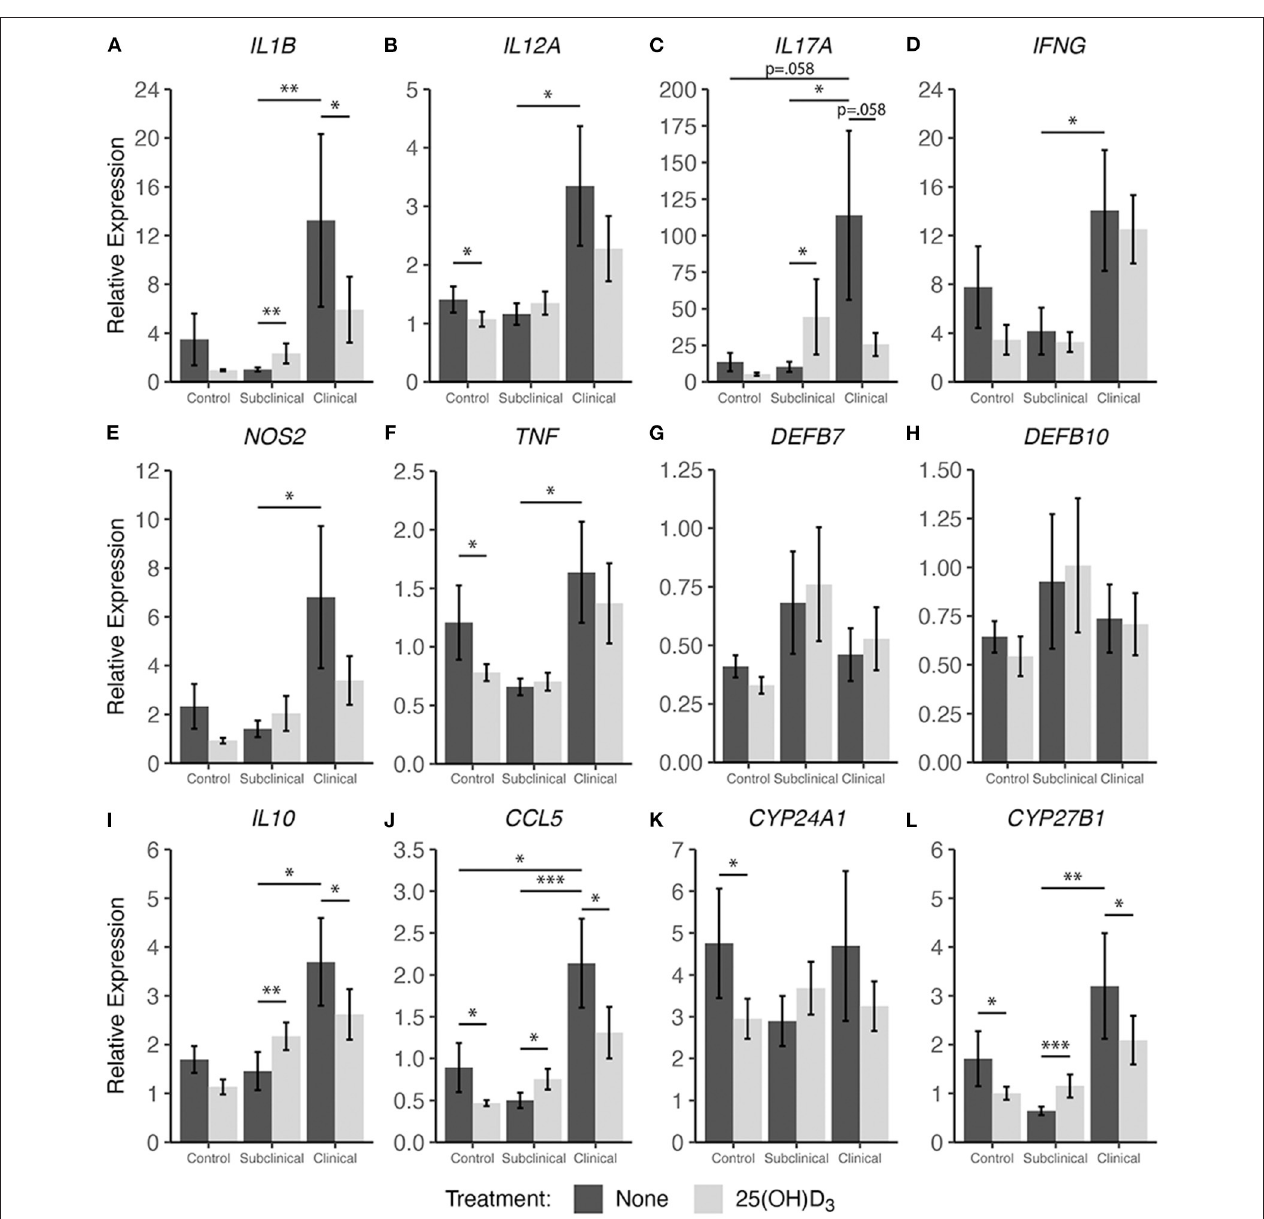
FIGURE 5 | Cytokine gene expression from PBMCs isolated from naturally infected dairy cattle (subclinical n = 8 and clinical n = 8) or noninfected controls ( n = 8). Cells were cultured 24 hrs with culture media or whole cell MAP sonicate (MPS) ± 100ng/ml 25(OH)D 3 . Extraction and purification of RNA was performed using Qiagen RNeasy Mini kits and was reverse transcribed with Superscript IV. Gene expression for (A) IL1B , (B) IL12A , (C) IL17A , (D) IFNG , (E) NOS2 , (F) TNF , (G) DEFB7 , (H) DEFB10 , (I) IL10 , (J) CCL5 , (K) CYP24A1 , and (L) CYP27B1 were determined using TaqMan assays and were normalized to eukaryotic 18S rRNA reference gene. Data were analyzed using the 2 − 11 Ct method and are presented as the mean relative gene expression (RQ) ± SE compared to each sample’s respective non-stimulated (NS) control. Statistics were performed on 11 Ct values and significance levels are as follows: * < 0.05,** < 0.01,*** < 0.001.